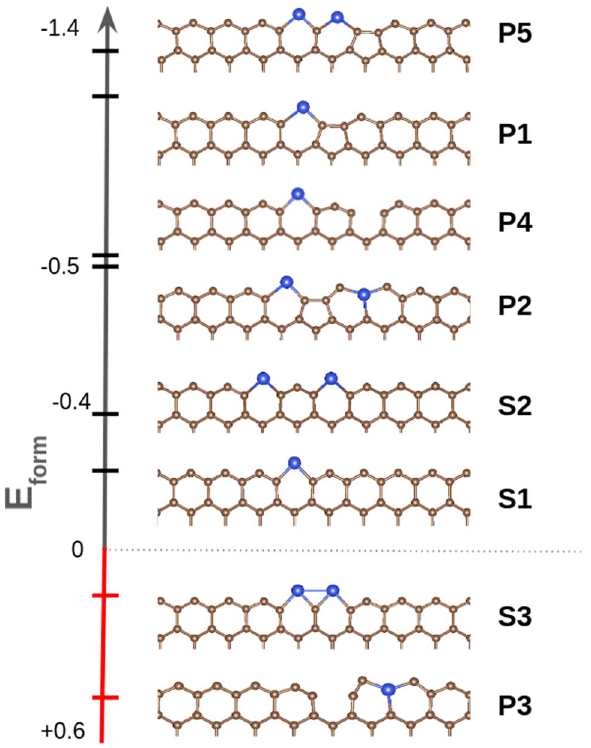
Figure 1. Representative Si-doped ZGNR structures along with their formation energies ( E form ) in eV. Carbon and silicon atoms are depicted in brown and blue,